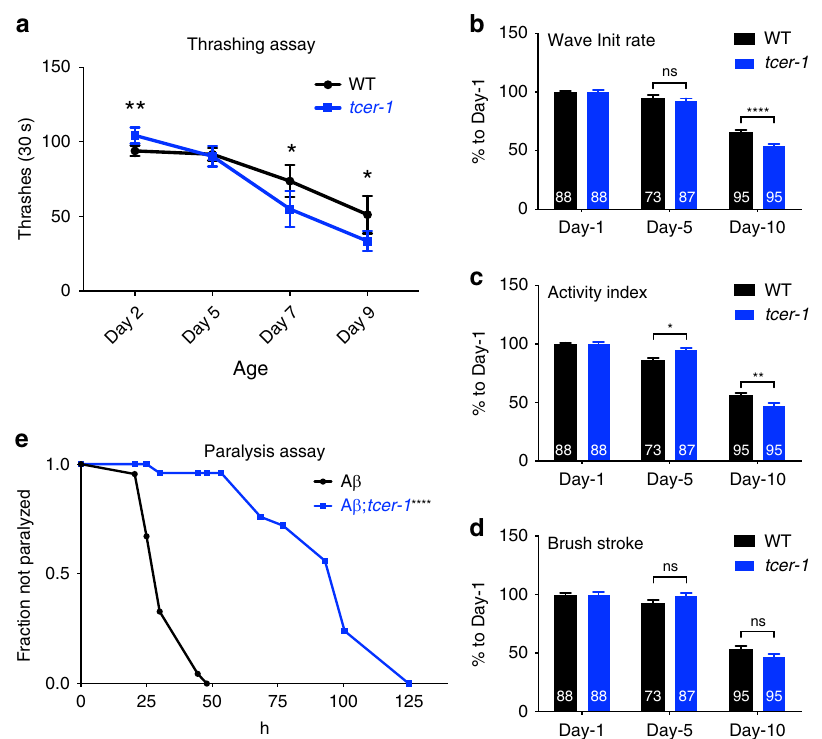
Fig. 8 Young tcer-1 mutants exhibit improvement in some healthspan parameters. a Thrashing ef fi ciency compared between wild-type (WT, black) and tcer-1 mutants (blue) at different ages. Data shown are combined from six independent biological replicates with 20 animals tested per strain, per replicate. Statistical signi fi cance was calculated using an unpaired two-tailed t test. b – d Measurement of change in swimming parameters with age in wild-type C. elegans (WT, black) and tcer-1 mutants (blue) quanti fi ed using CeleST 55 . In this longitudinal assay, the differences seen between the strains on day 1 of adulthood were not replicated but a clear reduction in day 10 tcer-1 mutants ’ wave initiation rate ( b , number of body waves initiated per minute) and activity index ( c , measure of overall swimming activity) was observed. Brush stroke ( d , depth of movement) was also reduced in the mutants but not in a statistically signi fi cant manner. Data combined from three independent biological replicates with number of animals tested for each genotype indicated on the bars. Statistical signi fi cance was calculated using two-way Anova, error bars represent standard error of the mean. e Loss of tcer-1 delays paralysis in A β proteotoxicity model. Onset of paralysis measured in the amyloid β proteotoxicity model strain GMC101 (A β , black) and A β strain carrying a tcer-1 mutation (A β ;tcer-1 , blue). Kaplan − Meier analysis for mean paralysis time: A β m = 33.1 h, n = 67; A β ; tcer-1 m = 95 h, n = 25. Asterisks indicate statistical signi fi cance <0.05 (*), <0.01 (**), and <0.0001 (****), ns not signi fi cant. Data from additional trials in Supplementary Fig.